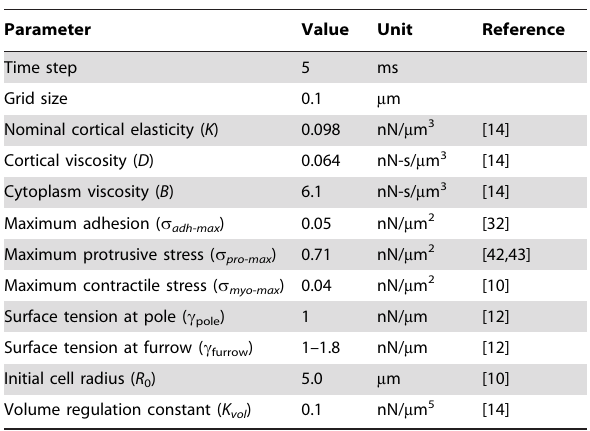
Table 2. Nominal Parameters.